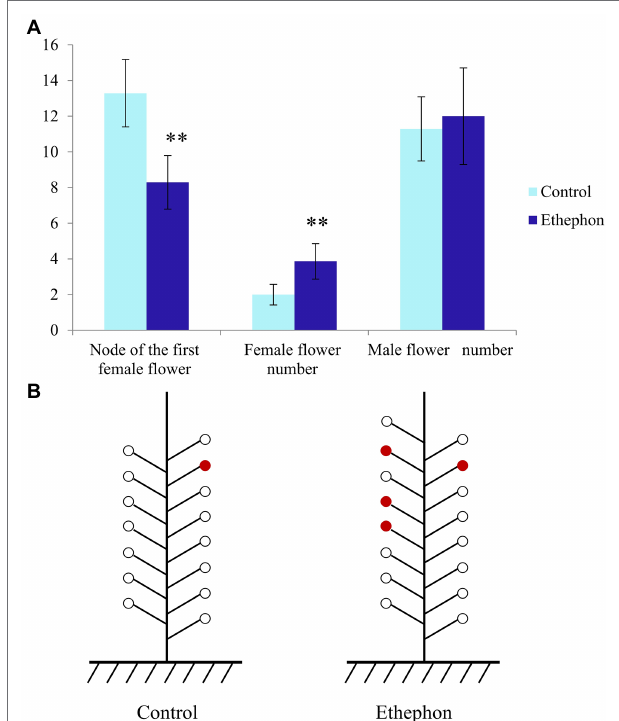
FIGURE 1 | Effect of ethephon on floral sex differentiation of pumpkin. (A) Node of the first female flower and the number of female flower and male flower in ethephon-treated and control plants. Double asterisk indicates a significant difference between control and ethephon-treated plants at 1% level as determined by Duncan’s new multiple range test. (B) The schematic diagram of sex differentiation of ethephon-treated and control plants.